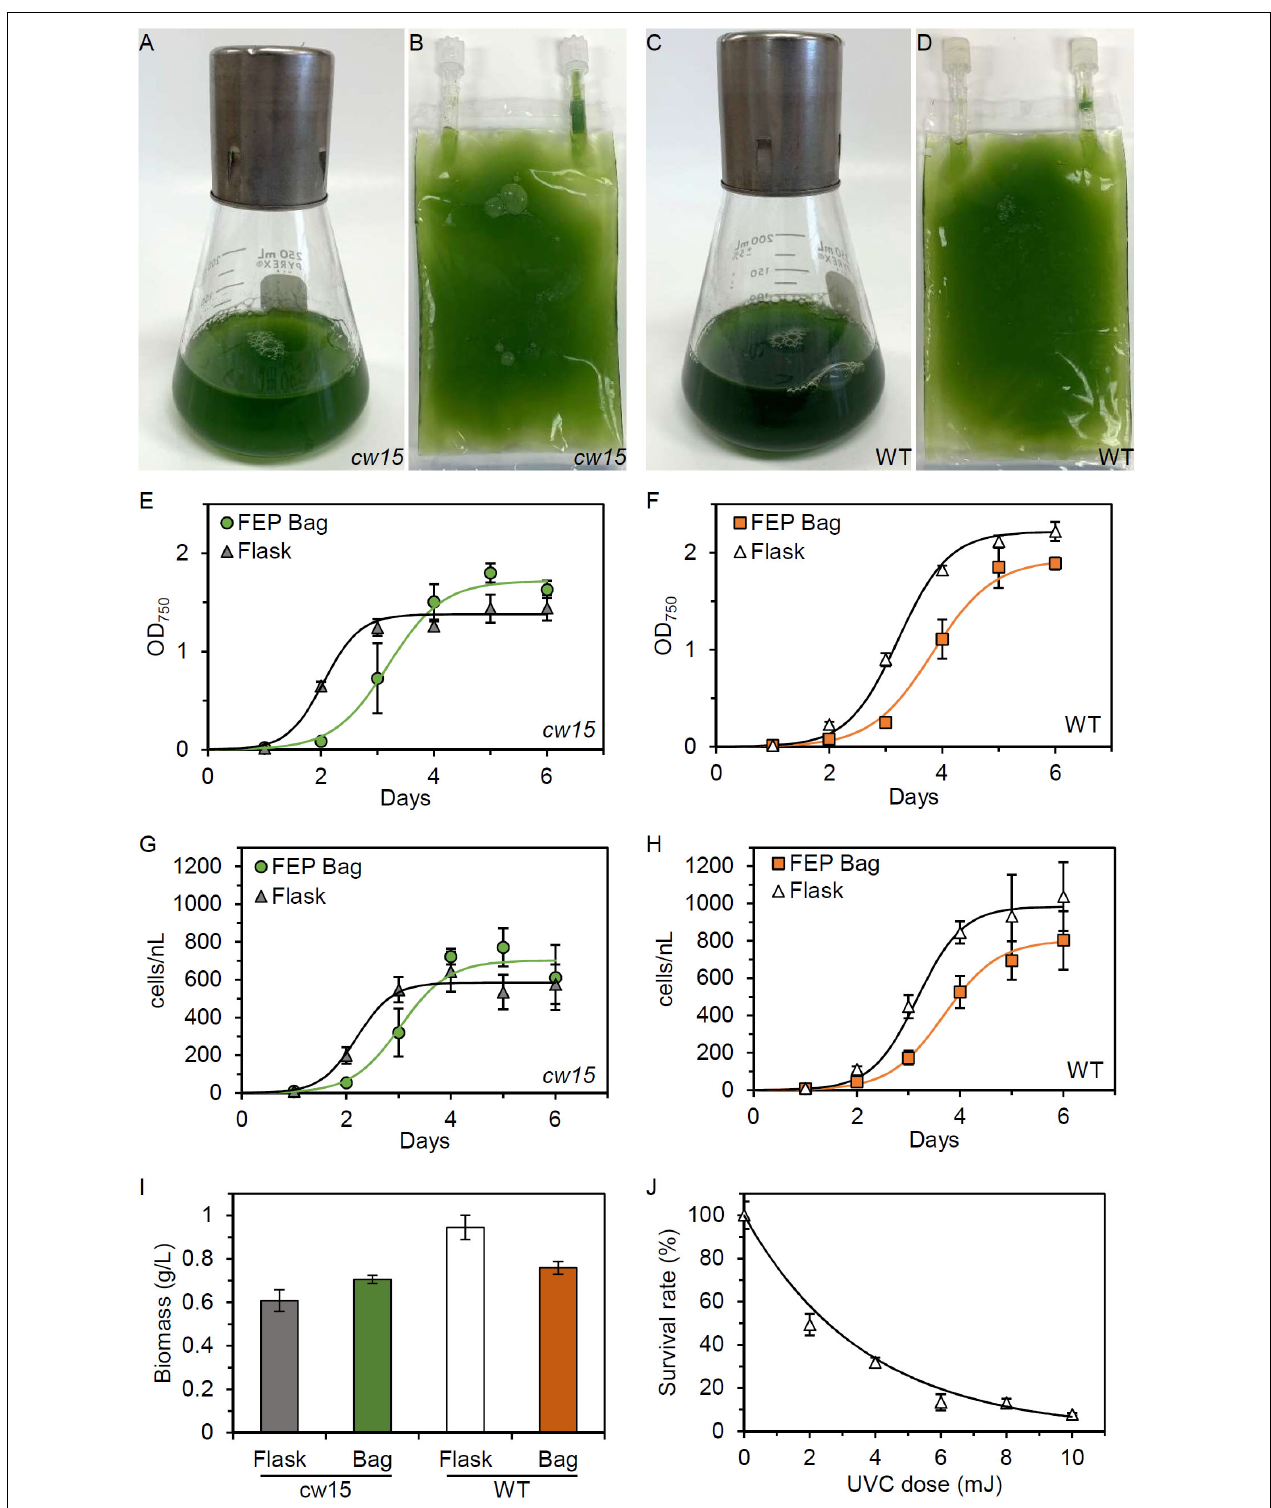
FIGURE 1 | Microalgae growth in FEP plastic culture bags. (A) Flask and (B) FEP bag culture of cw15 , CC-1883. (C) Flask and (D) FEP bag culture of wild-type (WT), CC-5082. Growth curves of cw15 (E,G) and WT (F,H) algae comparing flask and FEP bag cultures. Symbols are mean values ( n = 5, except n = 4 for cw15 FEP bags). Trend lines are logistic growth curve regressions. (I) Average biomass produced after 6 days of culture. (J) Dose-response of WT algae to UVC light. Trend line is an exponential regression. Error bars in all panels are standard deviation.